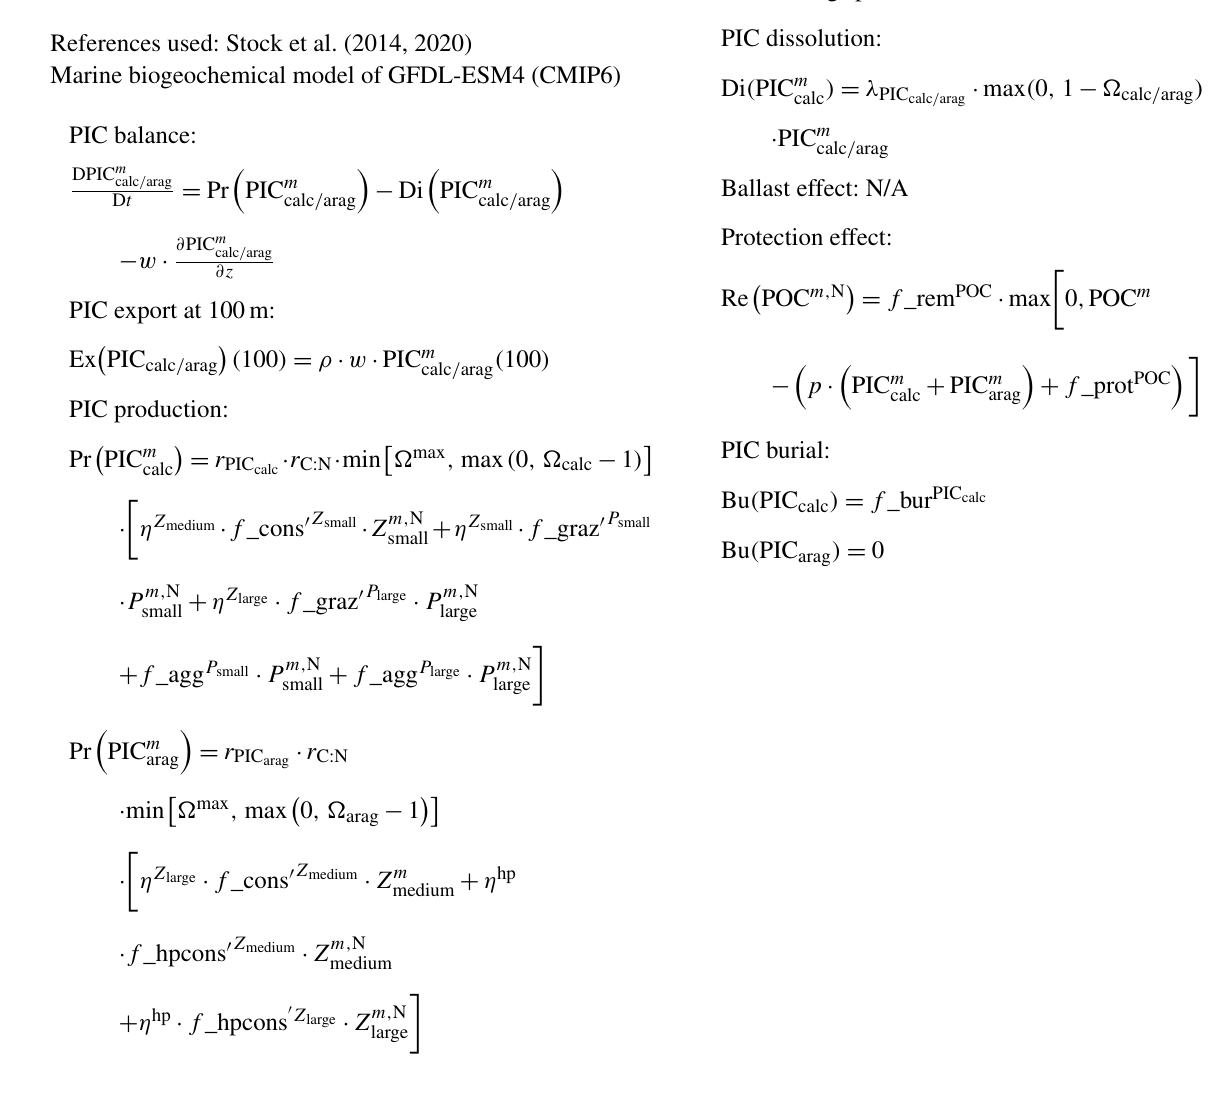
Table C19. COBALTv2 parameters. Variable/parameter Value